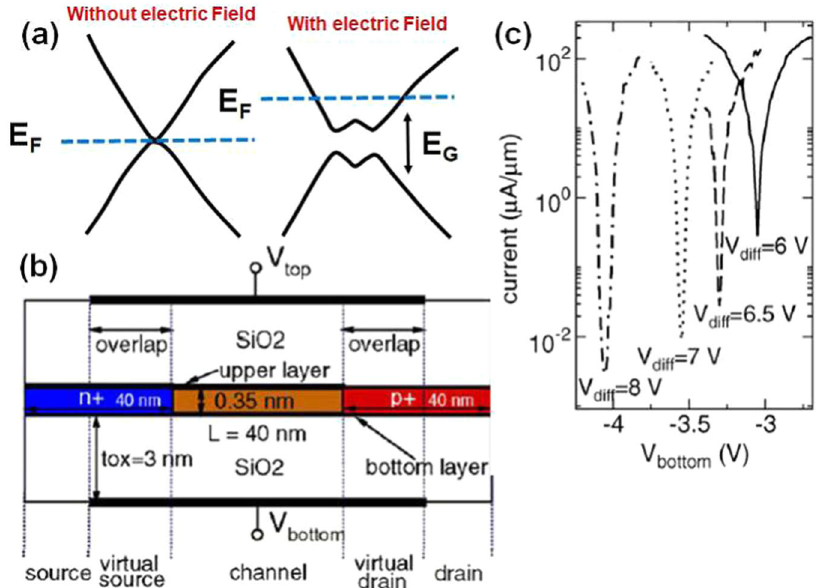
Fig. 5 Simulation Report of Nanoscale 2D GrNR-TFET. a Plots of E-k dispersion relation of 2L-Gr with and without applied transverse electric fi eld 171 . b Schematic and c transfer characteristics of DG 2L-Gr TFET, adapted with permission from 72 . Copyright (2009) IEEE.